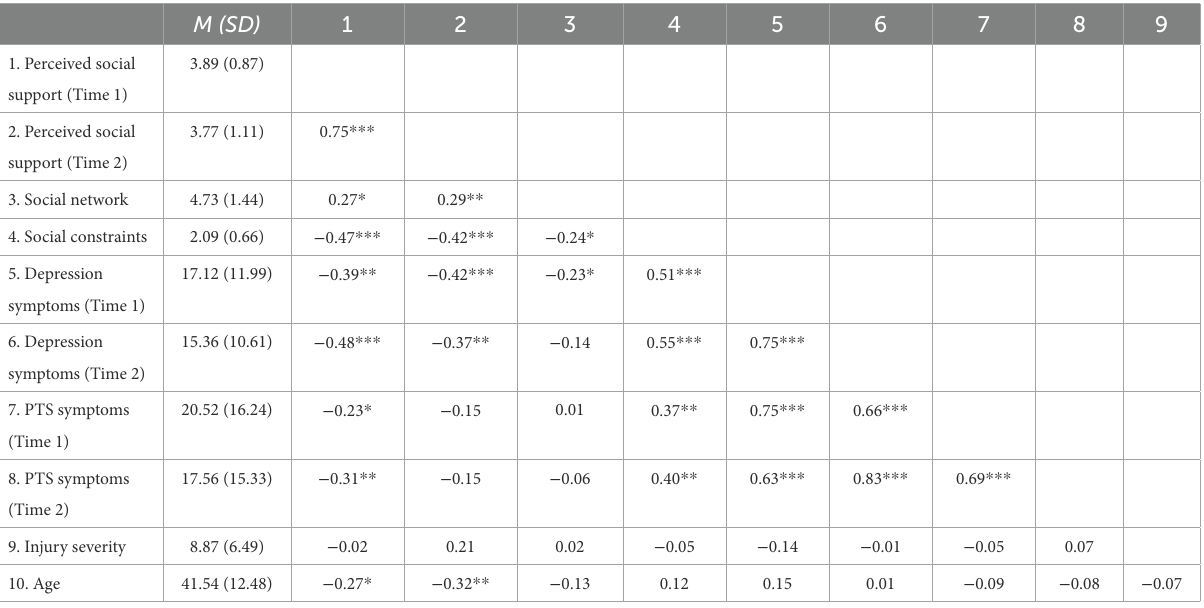
TABLE 2 Correlations between all key